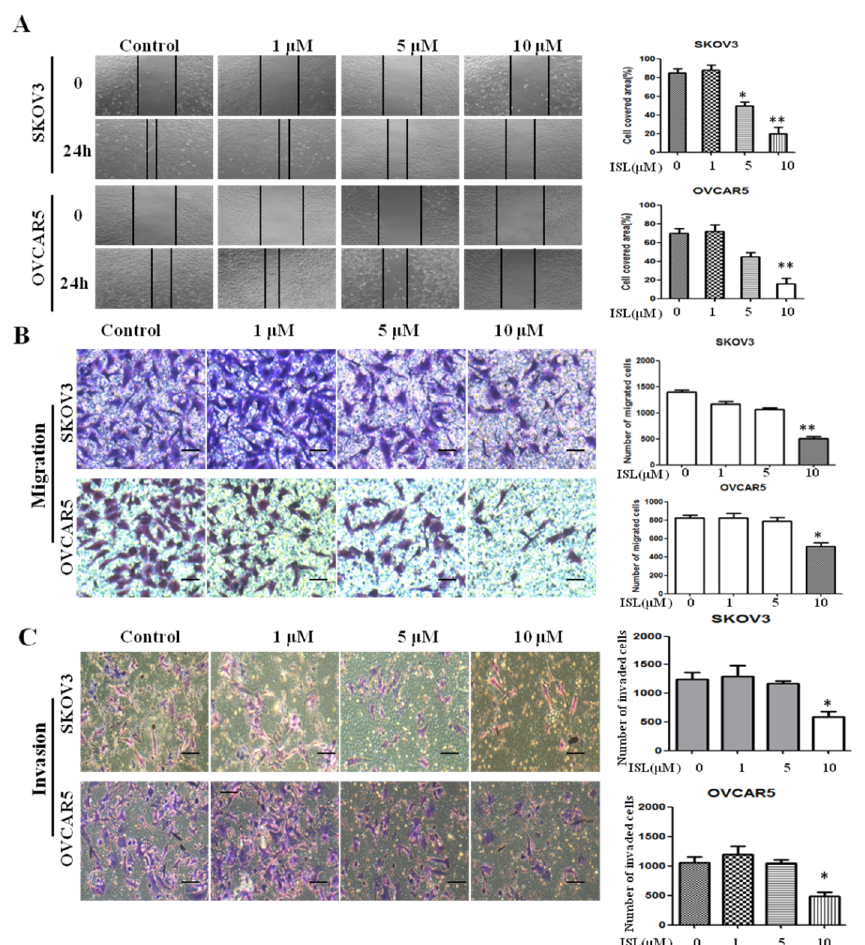
Figure 2. ISL inhibits the migration and invasion of SKOV3 and OVCAR5 cells. ( A ) Cells were grown to confluence, followed by treatment with vehicle or ISL (1, 5, and 10 µ M) for 24 h. A scratch was made with a fine pipette tip and cells were kept in medium containing 2% FBS with or without ISL. Images were taken at 0 and 24 h under a phase-contrast microscope. ( B ) Photomicrographs of migration to the lower side of chamber. Cells were pretreated with vehicle or ISL (1, 5, and 10 µ M) for 48 h, followed by analysis of cell migration using a transwell assay. Bar graph shows results of quantitative analysis of migration. The number of stained cells in five randomly selected fields was counted. ( C ) Photomicrographs of invasion to the lower side of chamber. Cells were pretreated with vehicle or ISL (1, 5, and 10 µ M) for 48 h, followed by analysis with a cell Matrigel invasion assay. Bar graph shows the results of quantitative analysis of invasion. The number of stained cells in five randomly selected fields was counted. Data are presented as mean ± SD. n = 3. 100 × magnification. Scale bars, 25 μm. Student t -test was used for statistical tests. * p < 0.05, ** p < 0.01 compared with the